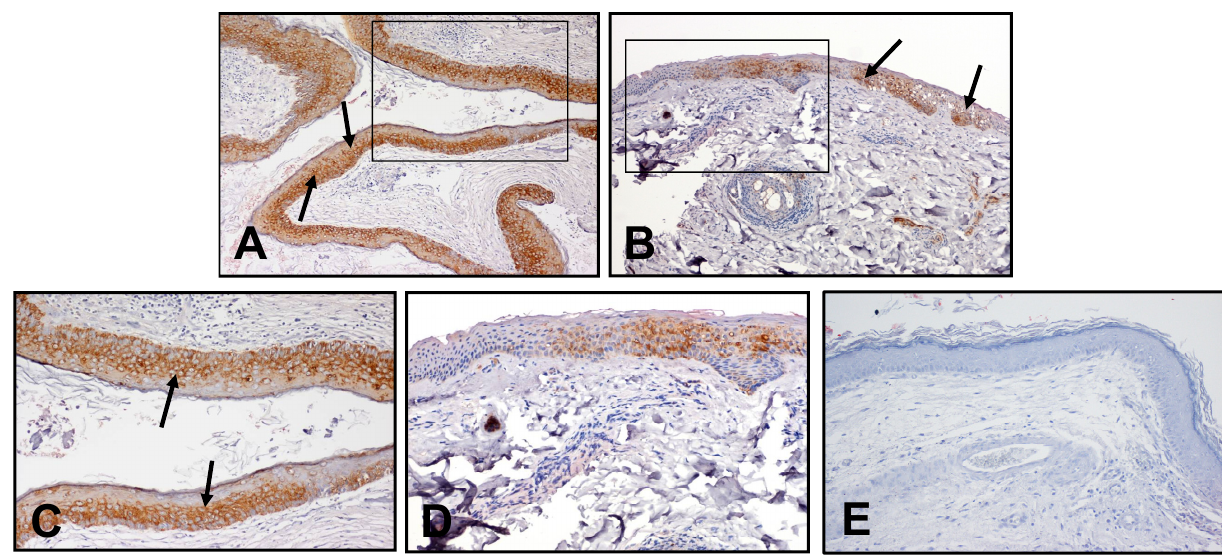
Figure 6. Immunoreactive staining of HSP27 for patient 5. ( A , C ) A strong and homogenous positive brownish staining in all layers of cholesteatoma epithelium (arrows). ( B , D ) Heterogeneous positive brownish staining in retroauricular skin (arrows) ( C ), ( D ). Immunoreactivity was confined to the cytoplasm of keratinocytes (arrows). The negative control was represented as ( E ). Magnification: ( A and B ) ×100; ( A inset, C ) ×200; ( B inset, D ) ×200; ( E )